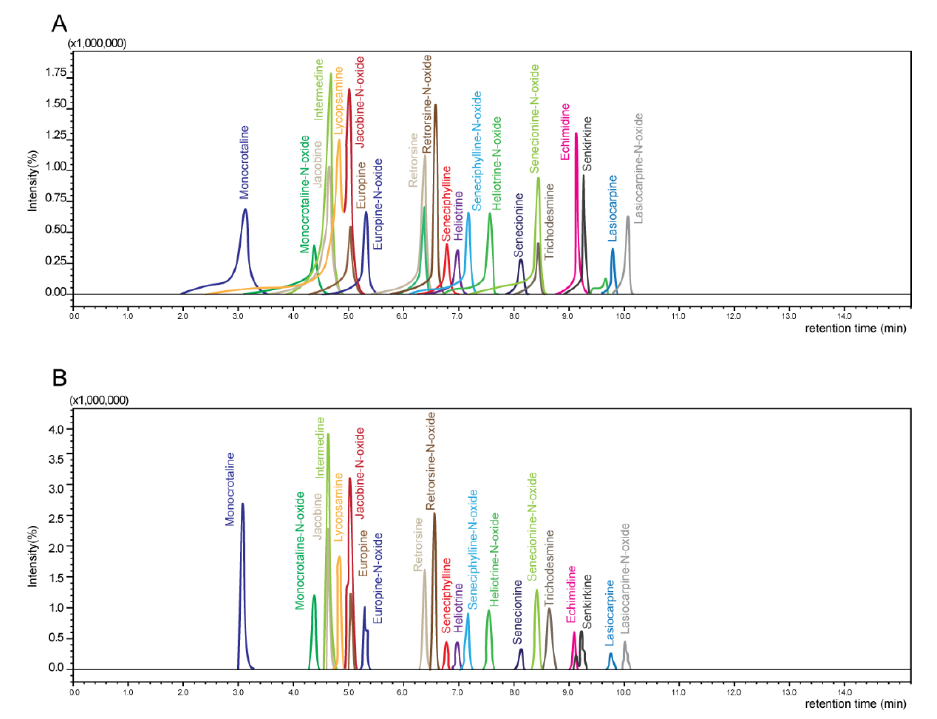
Figure 2. Comparison of sensitivity for reconstitution solvents between ( A ) 100% methanol and ( B ) 5% methanol.